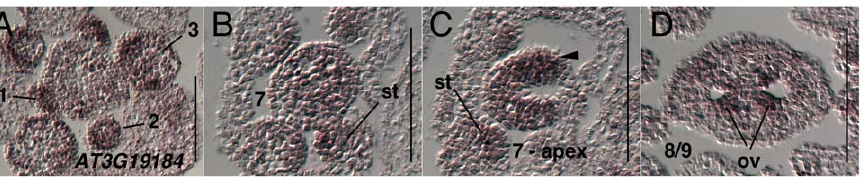
Figure 6. Results of insitu hybridization with AT3G19184 ( REM1 ) antisense probe. Numbers indicate floral stages. All panels show transverse (cross sectional) tissue orientation. Arrowheads indicate medial domain expression. Section in panel B is located 8 microns below section in panel C. ov - ovule; st- stamen primordia. Scale bars in all panels are 100 microns. All panels are Col-0 wild type tissue.